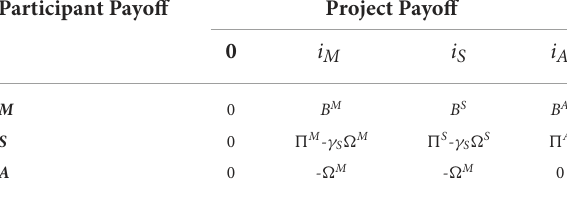
TABLE 2 Payoff incurred by the three-participant project.